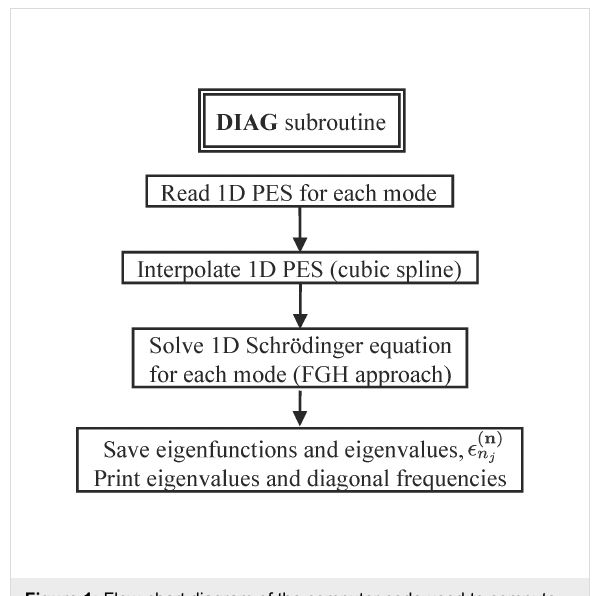
Figure 1: Flow-chart diagram of the computer code used to compute diagonal